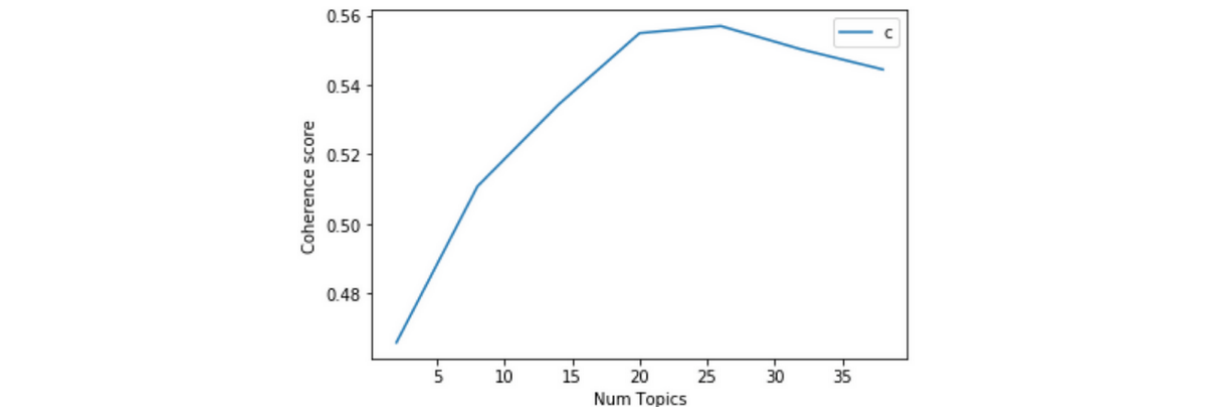
Figure 2. Coherence score for the topic